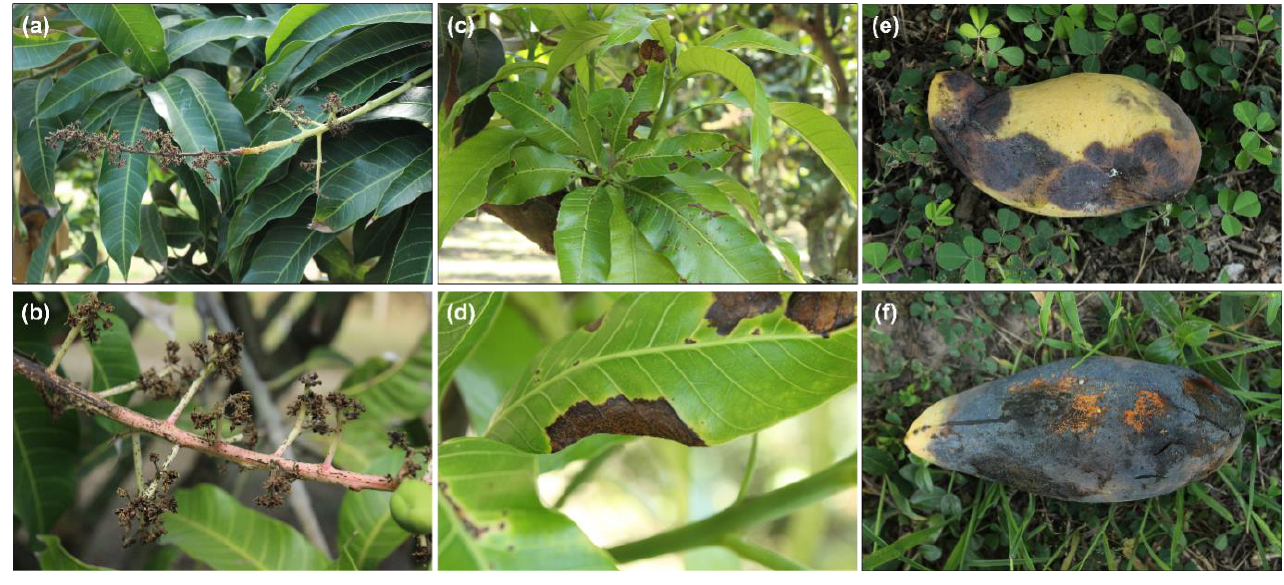
Figure 1. Visual symptoms of anthracnose caused by Colletotrichum spp. on mango tissues of NDMST cultivar; blight on inflorescence ( a , b ), irregular necrotic lesions on leaves ( c , d ) and irregular and sunken necrotic lesion on fruit ( e ) with abundant spore masses ( f ). Table 1. Collection of the Colletotrichum isolates with their geographical information. All isolates were from the NDMST